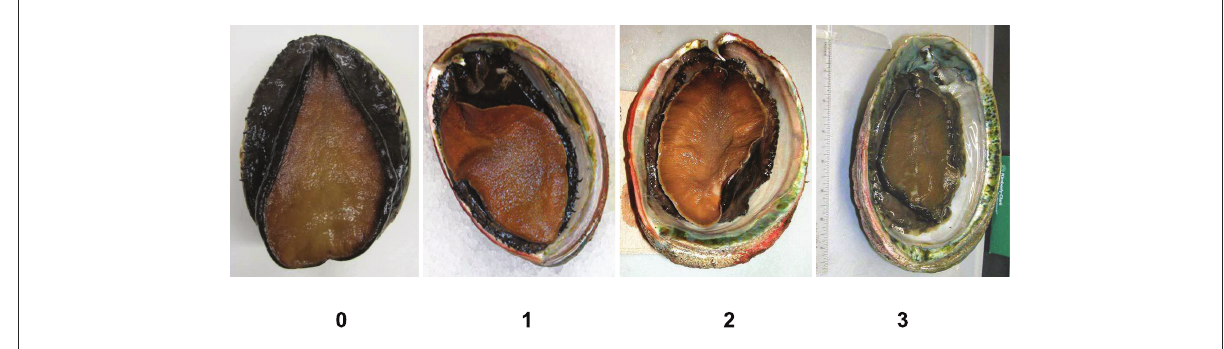
FIGURE3 Abalone body shrinkage scores (0–3; increasing in shrinkage from no shrinkage 0 on the left to right severe shrinkage).